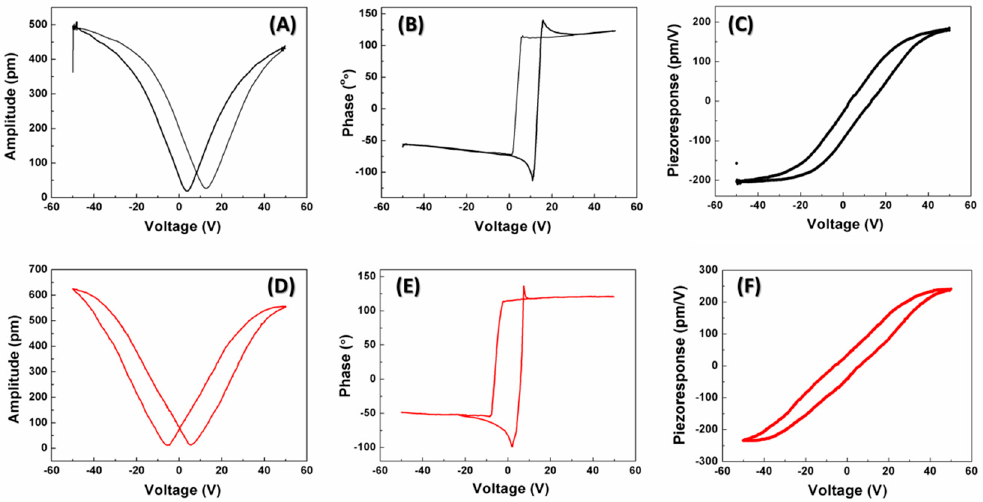
Figure 5. ( A ) Amplitude-voltage; ( B ) phase-voltage and ( C ) piezoelectric hysteresis loops of PMN-PT film before transfer; ( D ) amplitude-voltage; ( E ) phase-voltage and ( F ) piezoelectric hysteresis loop of PMN-PT film after transfer.